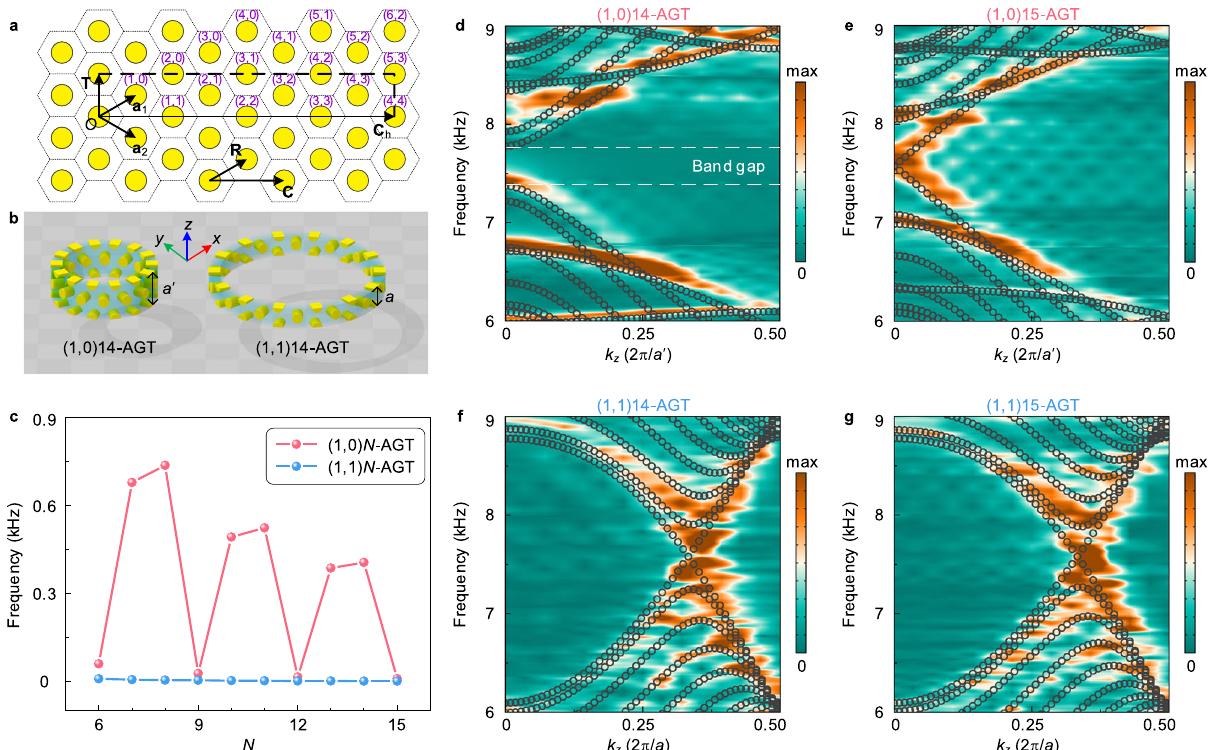
Fig. 2 | Sonic tubular dispersion engineering. a Chiral index map of the unrolled AGT,withtopology-speci fi cvectorsforthearmchairAGT. b Schematicsoftheunit cellsofa(1,0)14-AGT(leftpanel)anda(1,1)14-AGT(rightpanel),whichareperiodic along the tube axis. c Gap width vs. circumferential units N for a (1, 0) N -AGT (red)